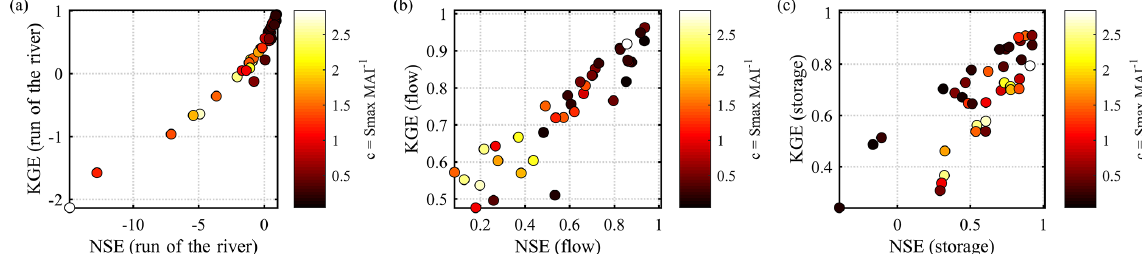
Figure 5. Scatter plot between KGE and NSE, with regulation scale represented in terms of c . (a) KGE and NSE on no-reservoir condition, (b) KGE and NSE on DZTR release, and (c) KGE and NSE on DZTR